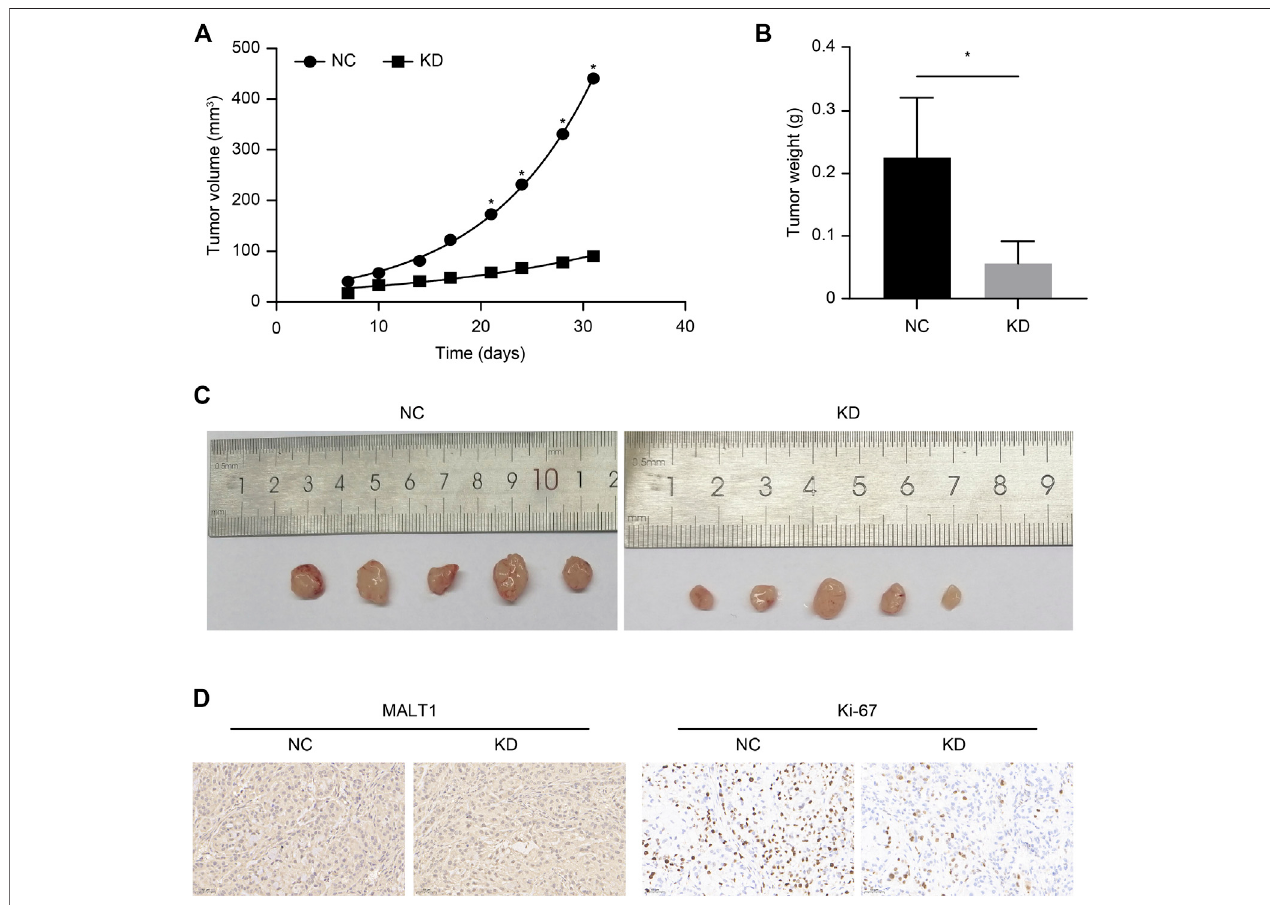
FIGURE 4 | Subcutaneous xenotransplantation of PC-3 human PCa cells in BALB/c nude mice. Comparison of the volume of xenografts between the NC (shCtrl) and KD (shMALT1) groups of mice. (A) Comparison of the volume and (B) weight of xenografts on day 31 post-inoculation between the NC and KD groups of mice. (C) Representative photographs of the tumors. (D) IHC analysis showing a decrease in MALT1 and Ki-67 expression.